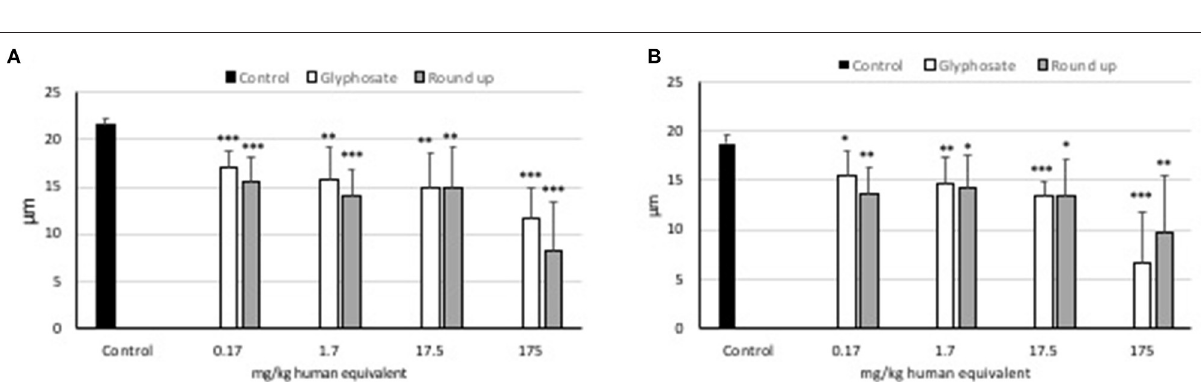
of Roundup Bioflow compared to controls in both L929 models and Caco2 models ( Figure 4